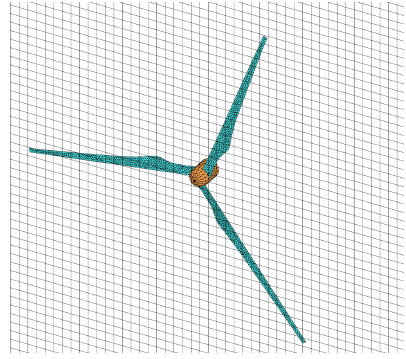
Figure 5. Cartesian grid discretizing the background fluid domain and triangular mesh discretizing the AS model for the rotor and the nacelle employed in VFS-Wind solver